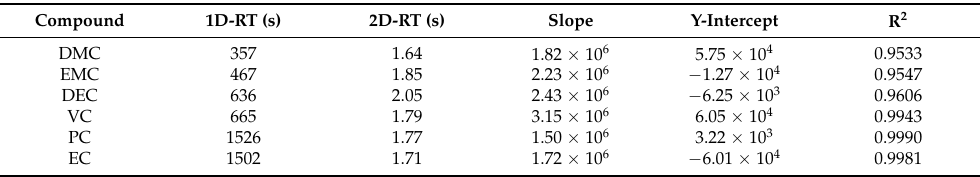
Table 5. GC × GC/EI TOF MS calibration results, including the retention times and linear correlation parameters for common organic solvents found in Li-ion